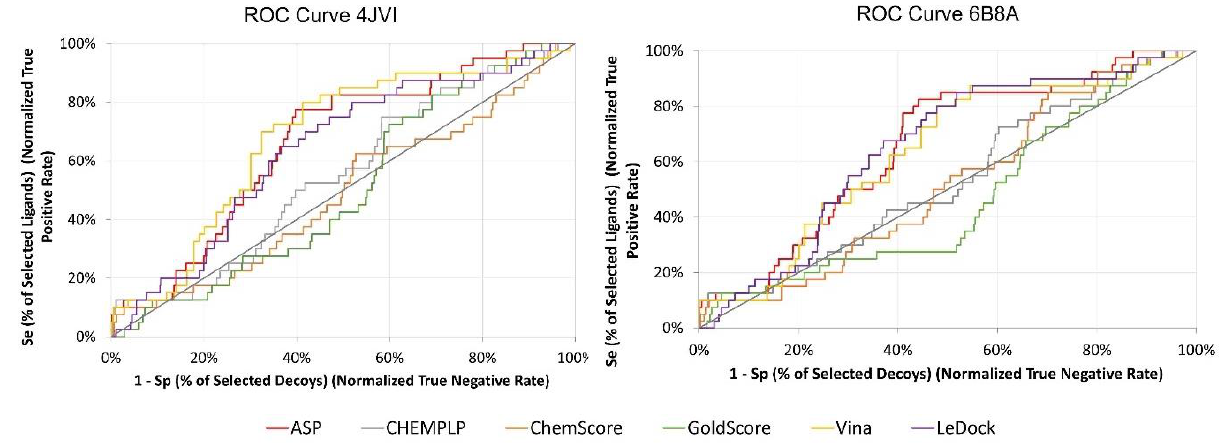
Figure 3. ROC curves for 4JVI and